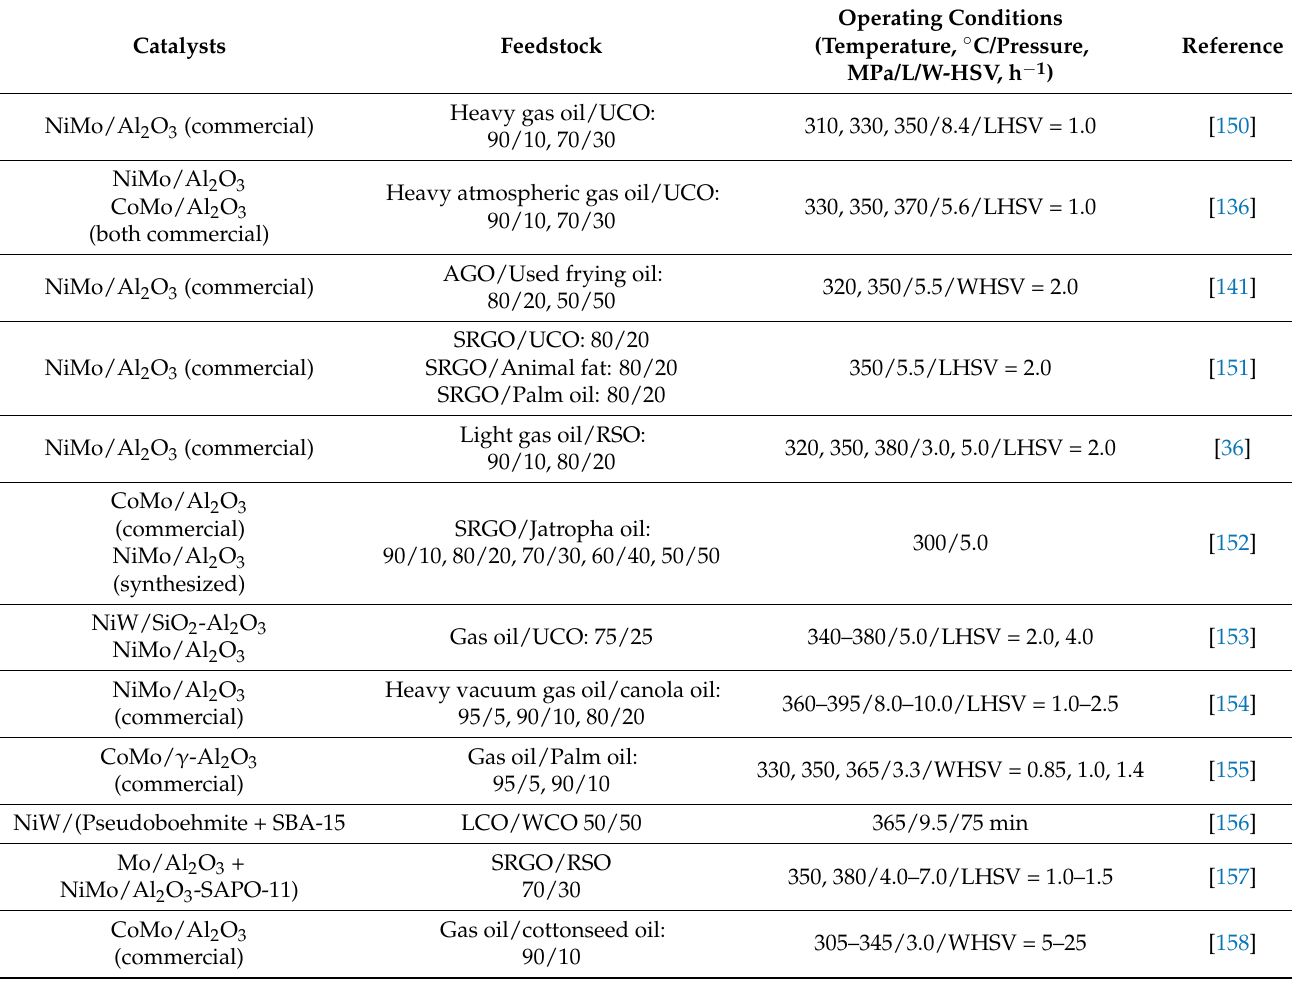
Table 6. The list of heterogeneous catalysts used for green